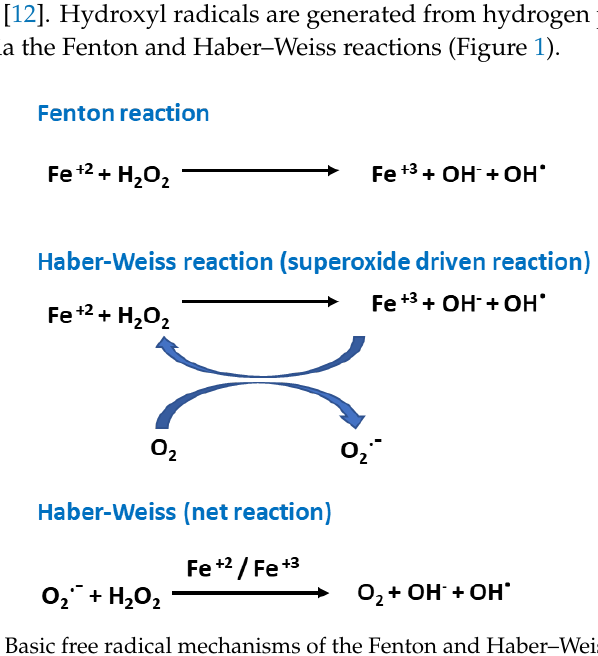
Figure 1. Basic free radical mechanisms of the Fenton and Haber–Weiss reactions.